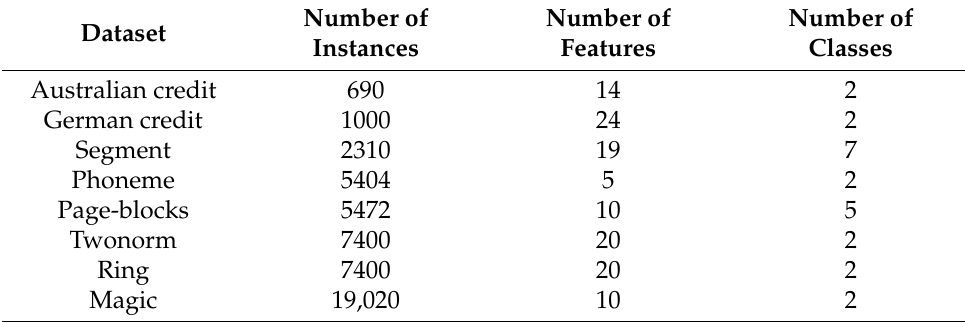
Table 2. Datasets used in the experiments.